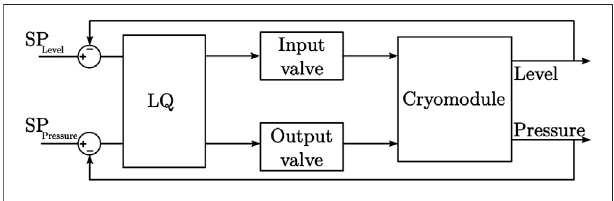
FIGURE 4 | Block diagram of the synthesized LQ regulator. SP designates the